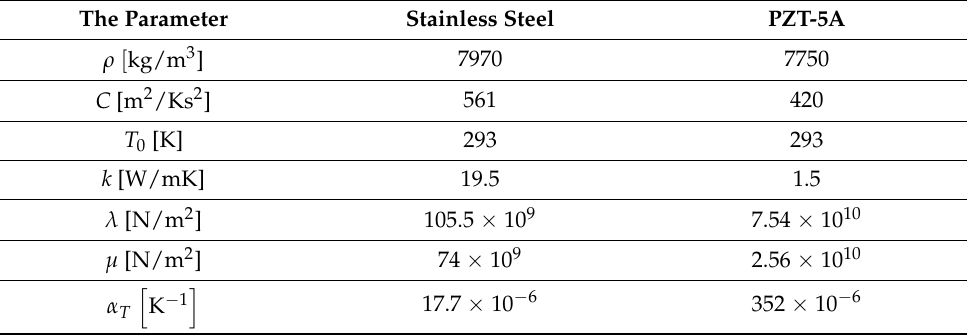
Table 1. The material properties.